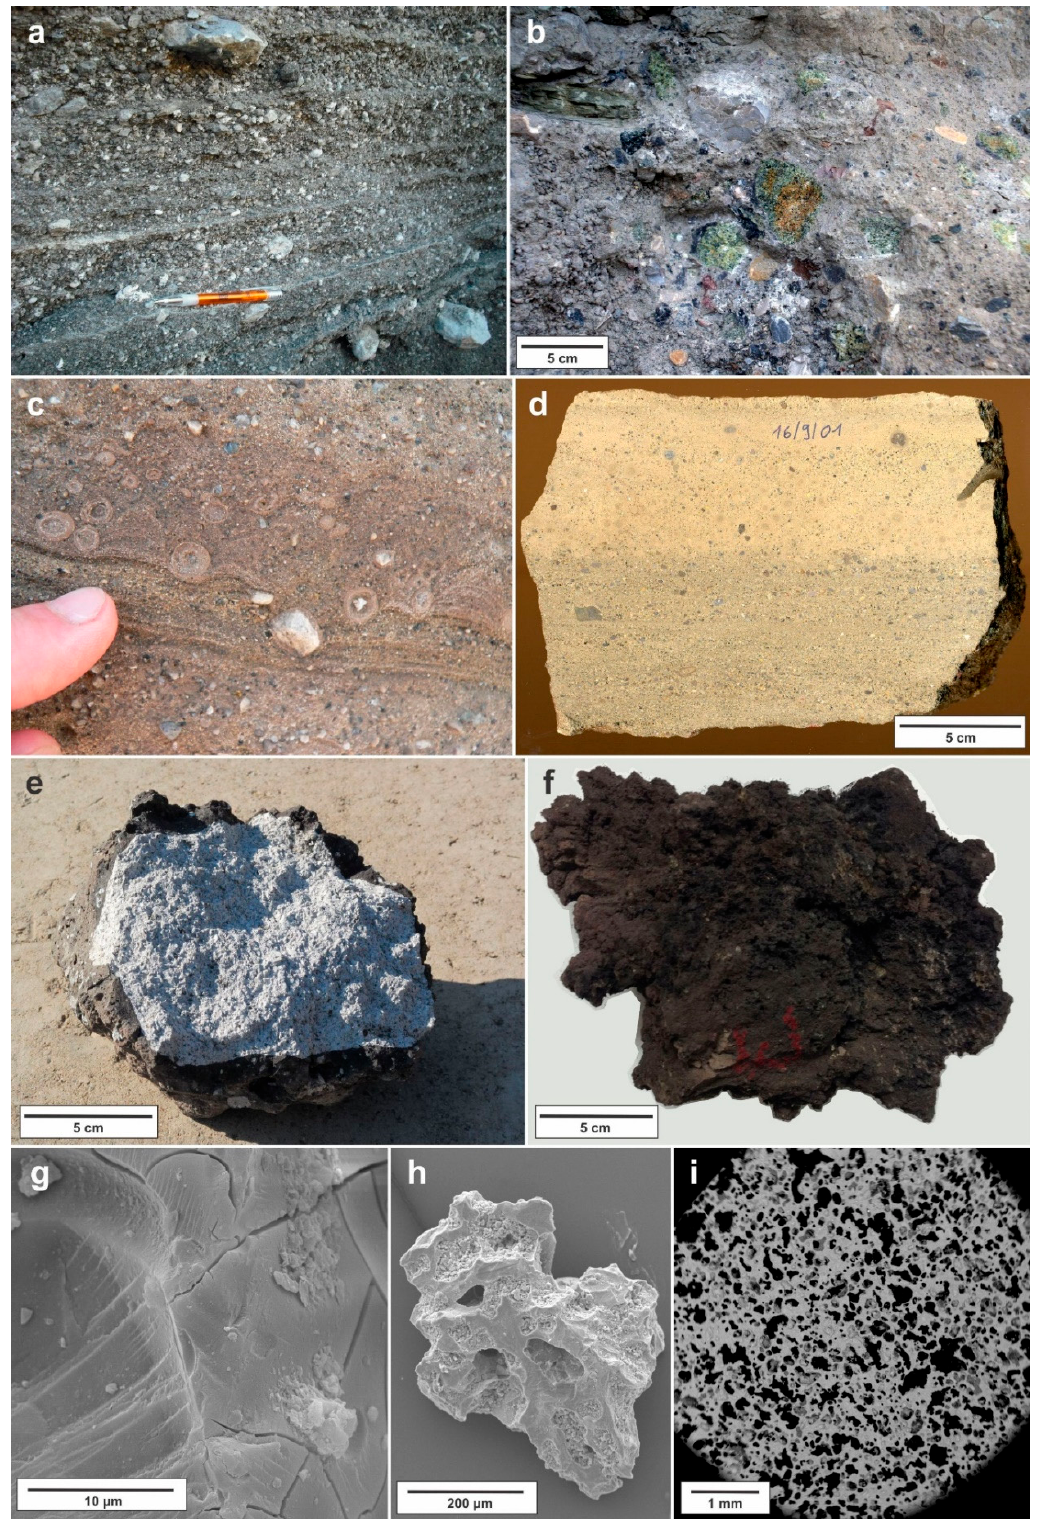
Figure 5. ( a )—Lithic-rich proximal deposits around the Joya Honda maar in San Luis Potosi, Mexico; ( b )—Lithic-rich pyroclastic flow deposit sourced from the Füzes maar in Szentb é kk á lla (Bakony-Balaton Highland Volcanic Field, Hungary); ( c )—Accretionary lapilli in pyroclastic surge deposits, Spiaggia Valle Muria, Lipari, Eolian Islands, Italy; ( d )—Typical phreatomagmatic lapilli tu ff and tu ff section (from the Bakony-Balaton Highland volcanic Field, Hungary) in hand-specimen with abundant accretionary lapilli; ( e )—Cauliflower-shaped loaded bomb from the Tongxin volcano, Arxan-Chaihe Volcanic